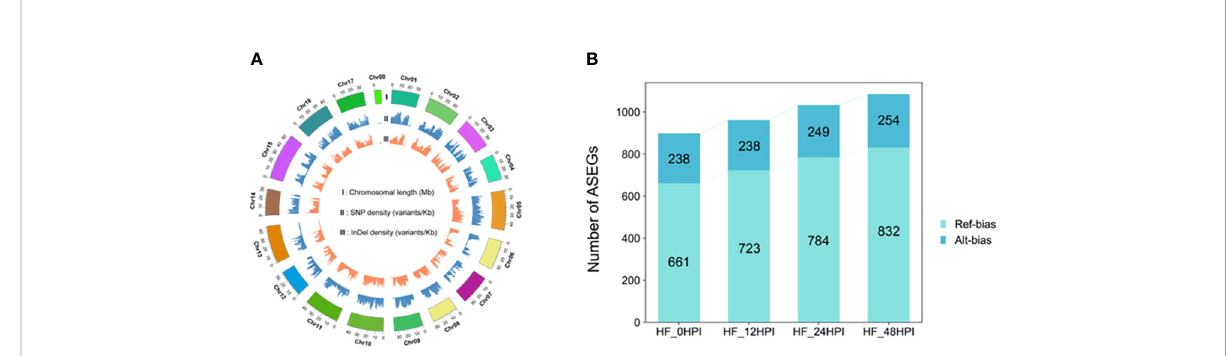
FIGURE 2 Identi fi cation of ASEGs. (A) Circos plot of HF resequencing data, chromosome length, SNP density, and indel density. (B) The number of ASEGs in HF leaves at 12, 24, and 48 h after AAAP inoculation and mock inoculation (0